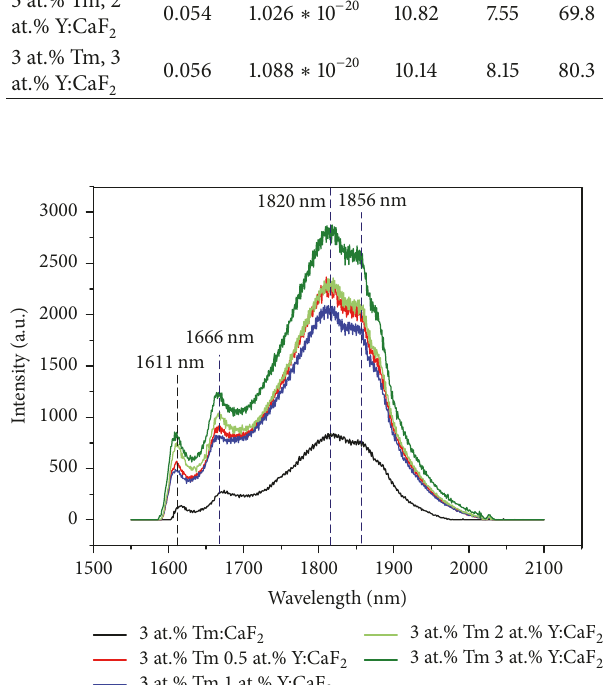
Figure 3: Fluorescence spectra for 3 F 4 - 3 H 6 transition of 3 at.% Tm, 𝑥 at.% Y CaF 2 crystals at 300 K.